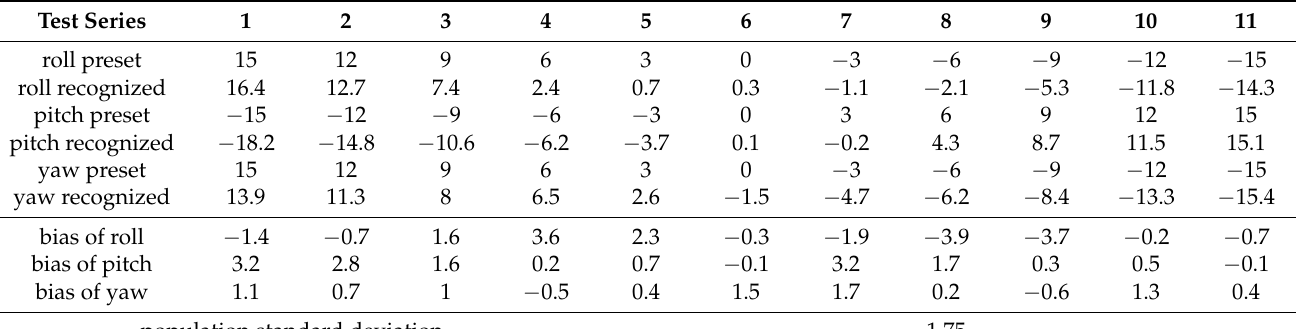
Table 2. Preset; detection values; and deviations of roll, pitch, and yaw of experiment 2 ( ◦